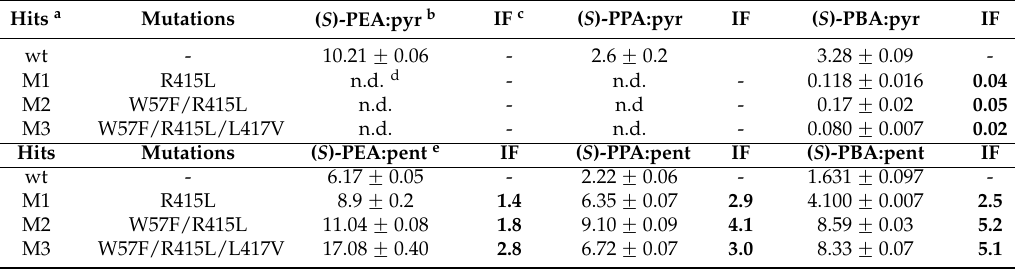
library screening. ( S )-PEA, ( S )-phenylethylamine; ( S )-PPA, ( S )-phenylpropylamine.